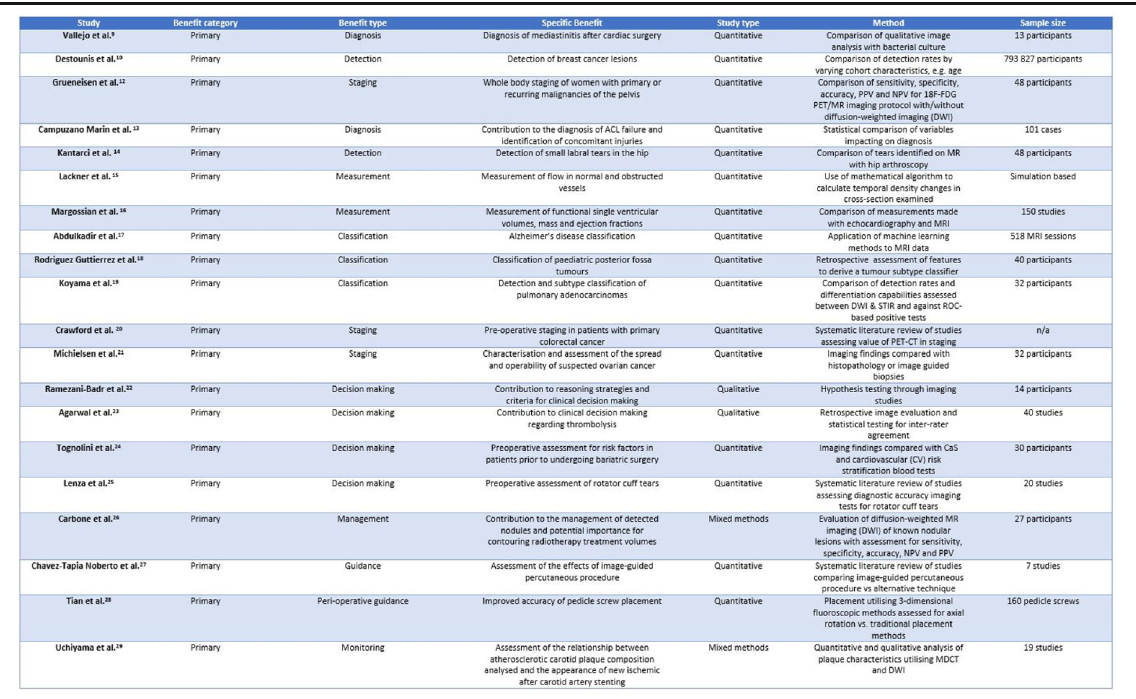
Table 2 An overview of study types and contents and the primary benefit